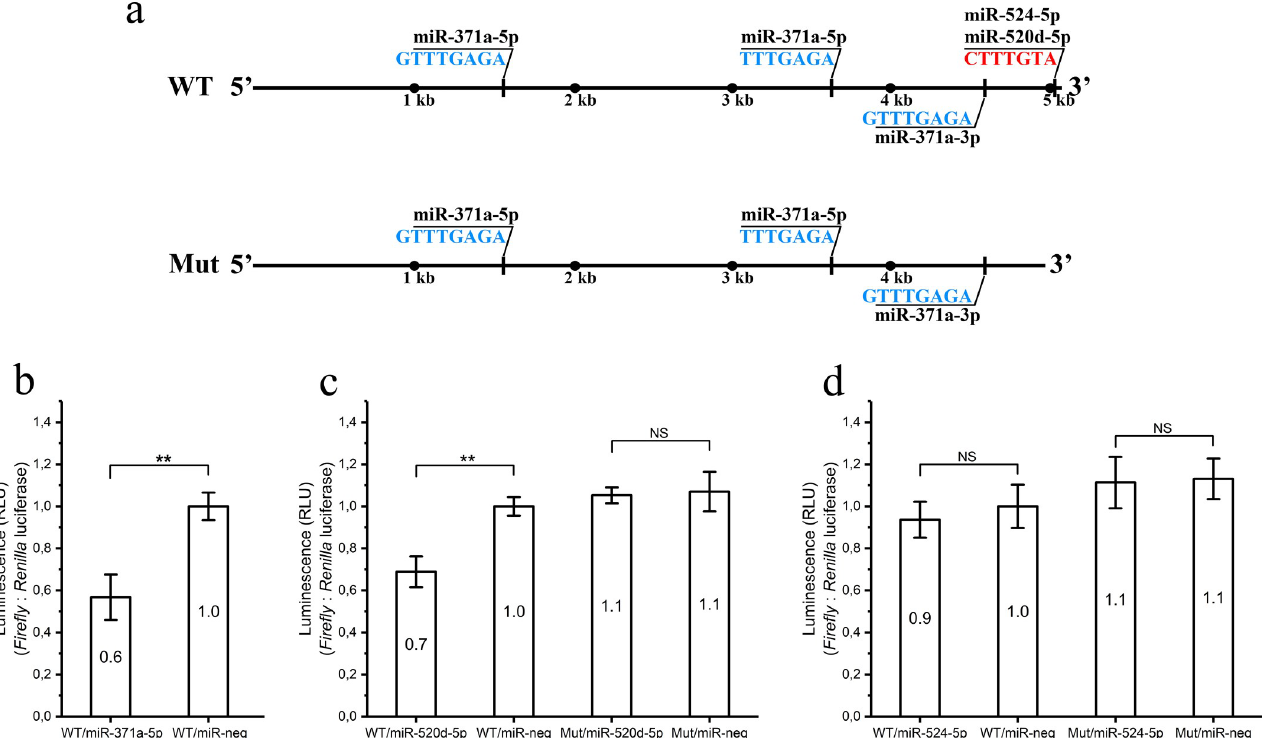
Fig 3. Binding of miRNAs in 3 0 UTR of CPPED1 . Seed locations of miRNAs analyzed for binding to the 3 0 UTR of CPPED1 by luciferase reporter assay (a). MiR-371a-5p has three seed locations, starting at 1602, 2033, and 4607 nucleotides. MiR-520d-5p and miR-524-5p share the same seed location in the end of 3 0 UTR of CPPED1 , which starts at nucleotide 5076. Seed locations are not to scale with respect to one another. For the luciferase assays, two variants of the 3 0 UTR of CPPED1 were constructed. One construct contained the full-length 3 0 UTR (WT). The other construct (Mut) lacked the 33 terminal nucleotides containing the miRNA binding sites for miR-520d-5p and miR-524-5p. Black dots roughly mark every thousand kilobases (kb). Bottom part of the figure shows luciferase reporter–based assays to detect binding of miR-371a-5p (b), miR-520d-5p (c), and miR-524-5p (d) mimics to the 3 0 UTR of CPPED1 mRNA. WT or Mut constructs were cotransfected with miR371a-5p mimic (WT/miR-371a-5p) (b), miR-520d-5p mimic (WT/miR-520d-5p or Mut/miR-520d-5p) (c), or miR-524- 5p mimic (WT/miR-524-5p or Mut/miR-524-5p) (d) into HEK-293T cells. For WT miR-neg and Mut miR-neg, the miRNA mimic negative control was cotransfected with WT or Mut constructs, respectively. Luciferase activities were measured by dual luciferase reporter assay, in which Firefly luciferase was the experimental reporter and Renilla luciferase the control reporter. Negative control values were set to 1.00 (WT/miR-neg), to which the rest of the samples were compared. Columns show the mean value of relative luciferase activity of six replicates; maximum and minimum values are also indicated. Statistically significant changes were determined by Mann–Whitney U test and are indicated by an asterisk ( p < 0.05) or two asterisks ( p < 0.01). NS, not significant.